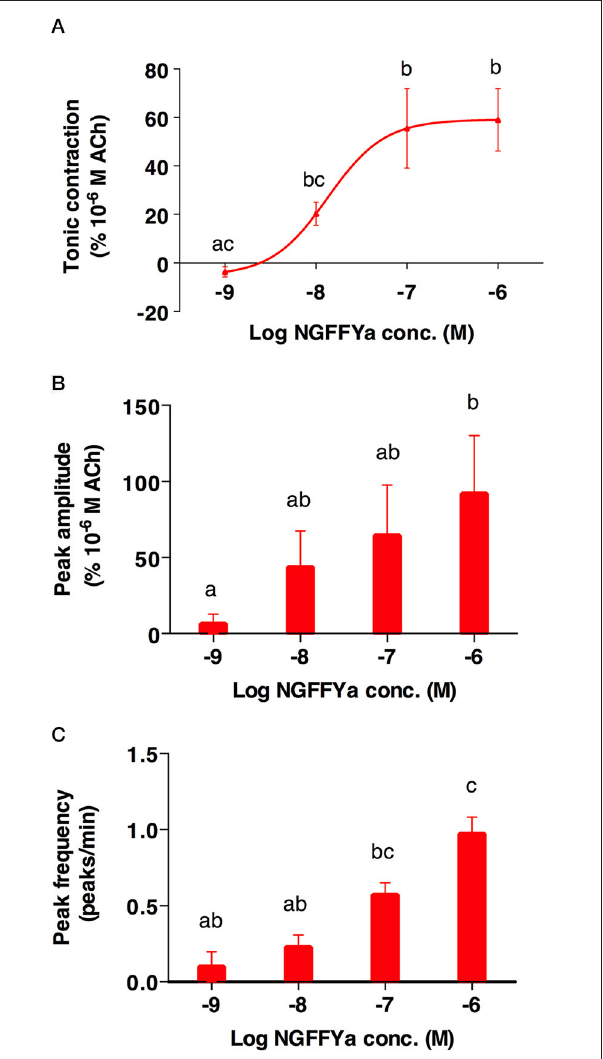
FIGURE 9 | The effects of NGFFYamide in causing both tonic and phasic contraction of tube foot preparations from A. rubens are concentration dependent. (A) Concentration-dependence of the effect of NGFFYamide in causing tonic contraction of tube feet. (B) Concentration-dependence of the effect of NGFFYamide on the peak amplitude of NGFFYamide-induced phasic contractions. (C) Concentration-dependence of the effect of NGFFYamide on the peak frequency of NGFFYamide-induced phasic contractions. The effects of NGFFYamide shown in (A,C) are normalized to the contractile effect observed with 10 − 6 M Acetylcholine (ACh). Results are expressed as mean ± s.e.m. ( n = 6). Different letters indicate statistically significant differences ( p < 0.05) by one-way ANOVA (A) or Kruskal-Wallis test (B,C) .